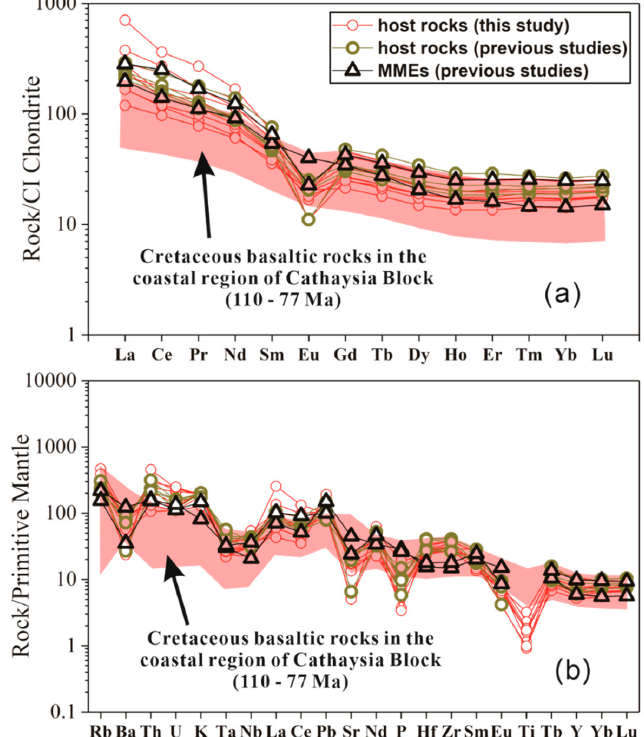
Figure 9. ( a ) Chondrite-normalized rare earth elements (REE, chondrite values are from Sun and McDonough. [74] and ( b ) primitive-mantle-normalized multi-element patterns (Primitive values are from McDonougha and Sun. [75] for Muchen rocks. Cretaceous basaltic rocks in the coastal region of Cathaysia Block are from Chen et al. [76] and Meng et al. [77]. Previous data of Muchen rocks are from Liu et al. [30].